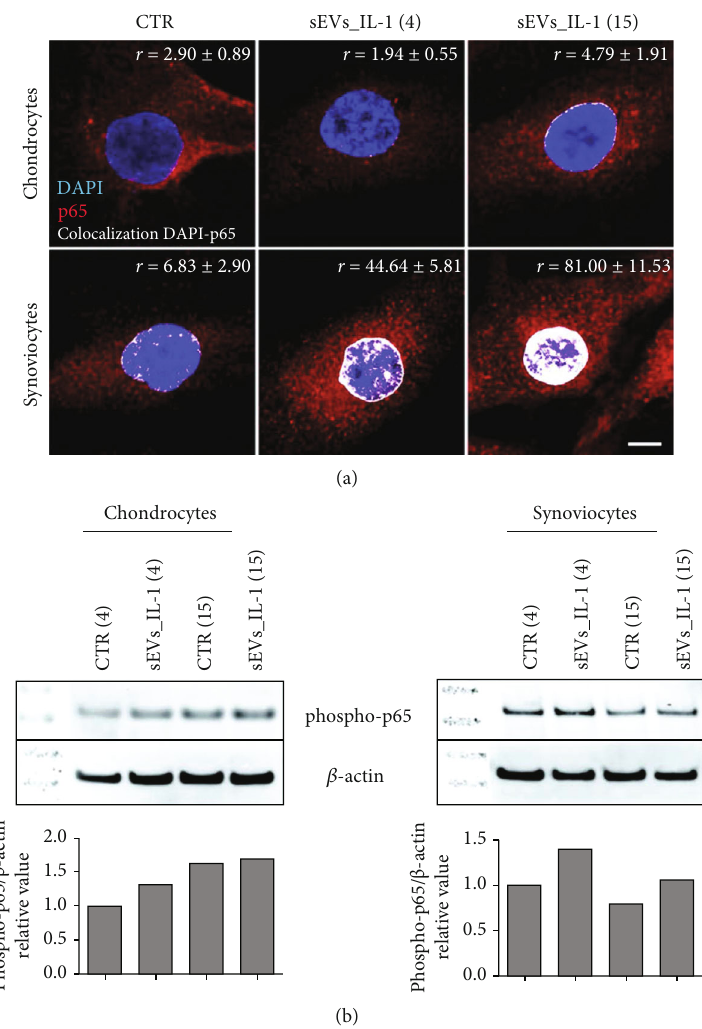
Figure 8: sEVs_IL-1 e ff ects on NF- κ B activation. (a) p65 immuno fl uorescence on chondrocytes (upper row) and synoviocytes (lower row) in control conditions (CTR) and at 4 and 15h after exposure to sEVs_IL-1. Scale bar: 10 μ m. Each image reports the level of the colocalization of the red (p65) to the blue (DNA) signal. The colocalization of the fl uorochromes (shown in white) was quanti fi ed using Pearson ’ s colocalization coe ffi cient ( r ), derived from 15 analyzed optical sections and expressed as percentage ± SD . 5 cells were considered for each condition. (b) Western blot analysis of samples of chondrocytes (left) and synoviocytes (right) in CTR or sEVs_IL-1 condition at both 4hr and 15 hr post-delivery. These samples were dedicated to western blot analysis of phosphorylation of p65 and β - actin as loading control. Lower graphs: relative quanti fi cation of phospho-p65 signal normalized to that of β